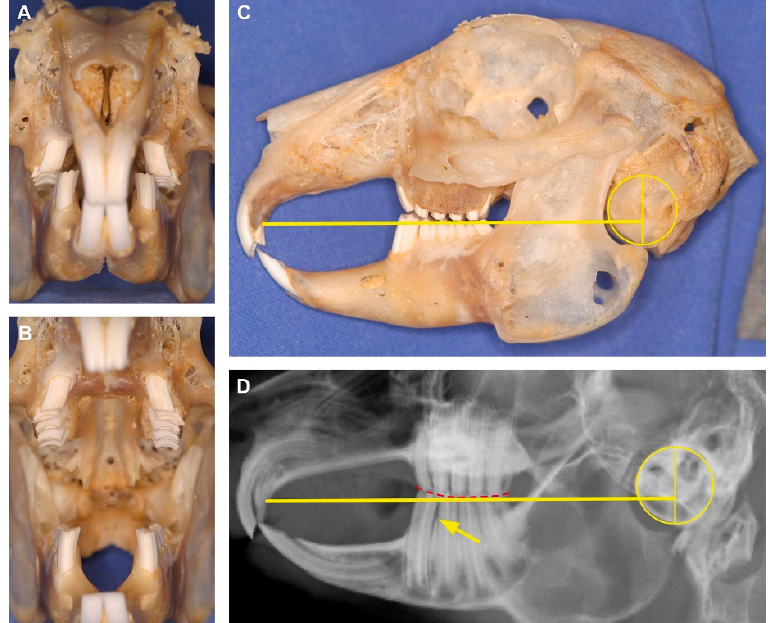
Figure 1. Example highlighting the importance to integrate effective, noninvasive techniques, such as radiography, in the clinical examination routine. ( A ) Rostrocaudal view of an apparently healthy dentition in a pet rabbit with mouth closed and ( B ) opened. ( C ) Lateral view of the skull with applied anatomical reference lines according to Böhmer and Crossley [11]. The yellow line begins at the rostral end of the hard palate immediately caudal to the second incisor and extends caudally to pass through the tympanic bulla at approximately one-third of its height. In healthy pet rabbits, it marks the physiological occlusal plane between maxillary and mandibular molars. In the present specimen, the occlusal line depicts a slight elongation of the clinical crown of the first lower cheek tooth (P3) which might be missed on clinical examination alone (see A and B). ( D ) The laterolateral X-ray is the gold standard to detect that this rabbit suffers from an early stage of malocclusion. The overlong mandibular P3 progressively bends rostrally causing a widening of the approximal space to the adjacent P4 (arrow). Due to the abnormally short clinical crown of the antagonist (maxillary P2), the occlusal plane of the cheek teeth shows a subtle caudal slant (red dashed line).